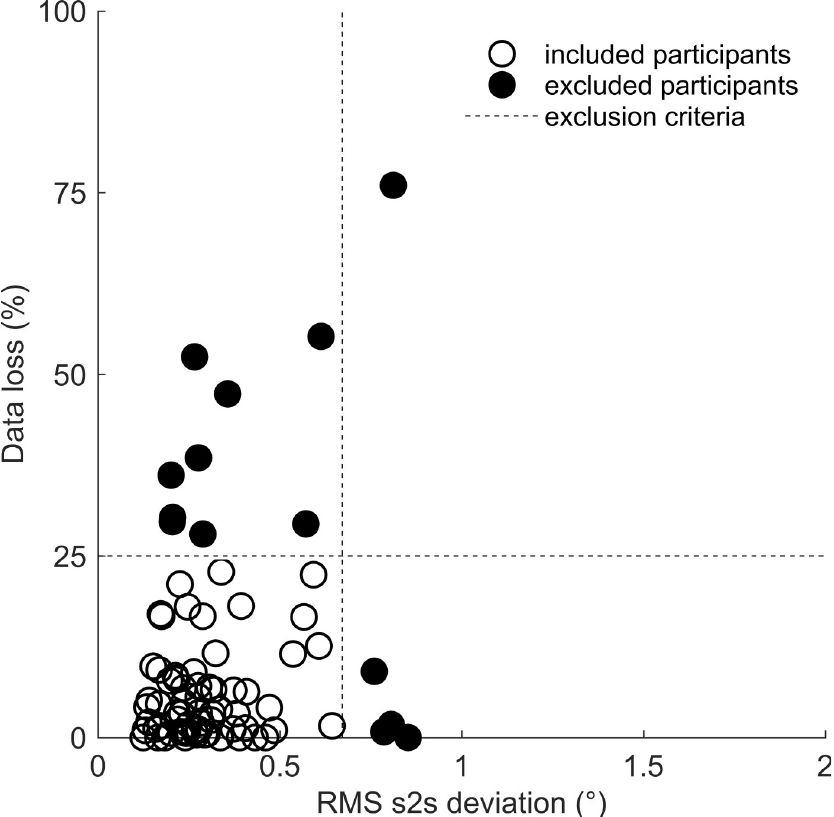
Fig 4. Visualization of data loss and RMS sample-to-sample (s2s) deviation. Every circle represents one participant. The dashed lines represent the exclusion criteria used; data loss > 25% on the y-axis, RMS s2s deviation (˚) > 2 SD’s above the mean on the x-axis. Open circles represent the included participants (N = 68), closed circles represent the excluded participants (N = 14).